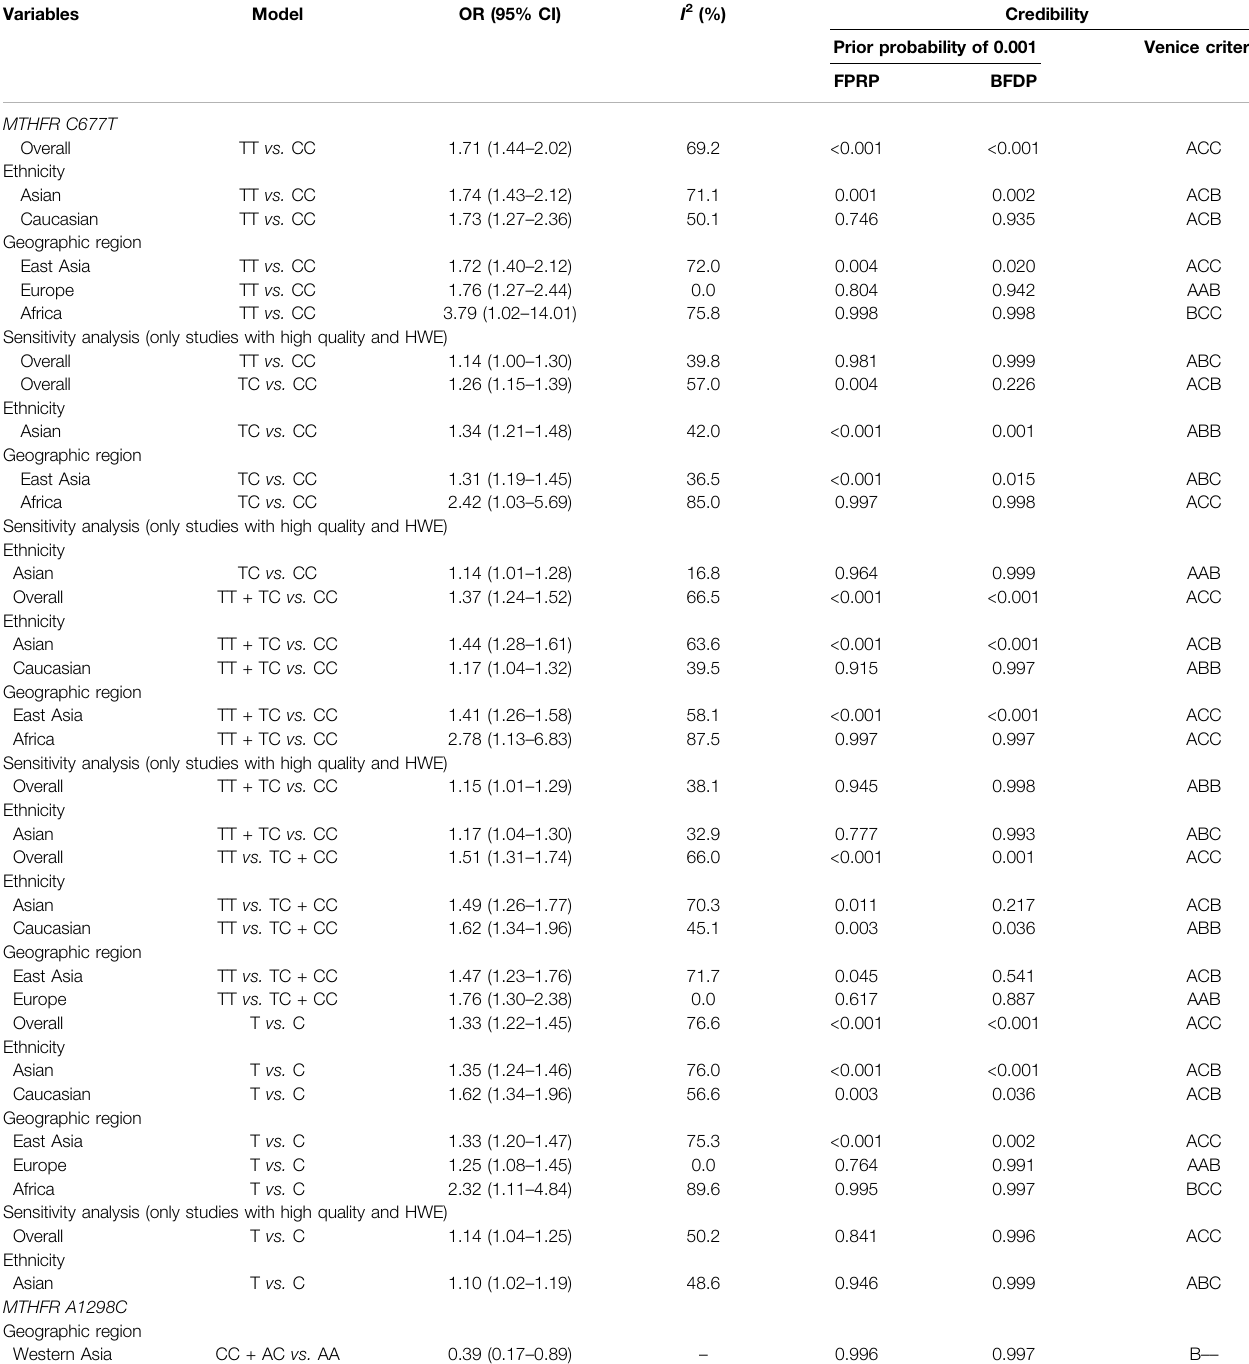
TABLE 7 | The credibility results of the positive effects after FPRP, BFDP, and Venice criterion.